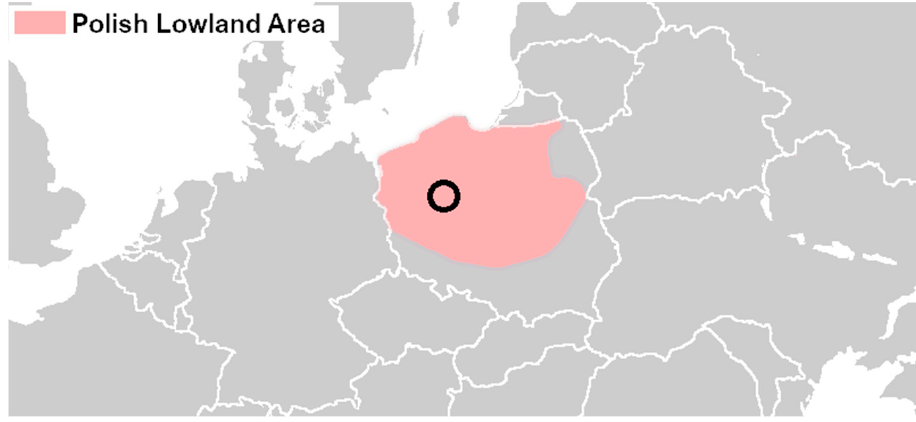
Figure 1. Geographic location of the city and the Polish Lowlands in Europe.